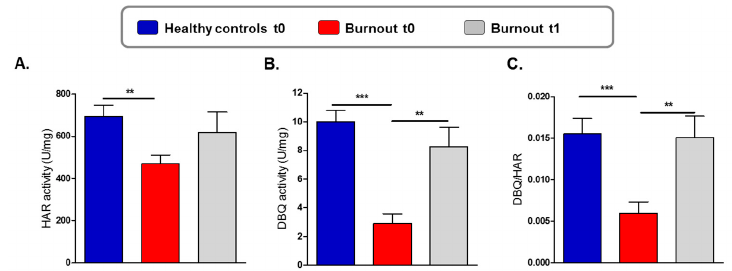
Figure 2. Reduced complex I content and activity in mitochondria from individuals with burnout and impact of physical activity. ( A ) Reduced complex I content as revealed by a significant reduction of NADH:HAR activity («HAR activity») in the group with burnout compared to healthy controls at baseline (t0). Student’s t test ** p = 0.0036. ( B ) Reduced “genuine” complex I activity as revealed by a significant reduction of NADH-ubiquinoneoxidoreductase (NADH:DBQ) activity («decylubiquinone (DBQ) activity) in the group with burnout compared to healthy controls at baseline (t0). Physical activity significantly increased DBQ activity in the burnout group at study end (t1). Student’s t test ** p = 0.0017, *** p < 0.0001. ( C ) The DBQ / HAR ratio was determined via normalization of complex I activity to the complex I content of the mitochondrial protein preparation. A significantly reduced DBQ / HAR ratio in individuals with burnout compared to healthy controls indicates a “functional” reduction of complex I activity at baseline (t0). Physical exercise improved significantly complex I activity in the burnout group. Student’s t test ** p = 0.0053, *** p = 0.0004. Values are represented by the mean ±